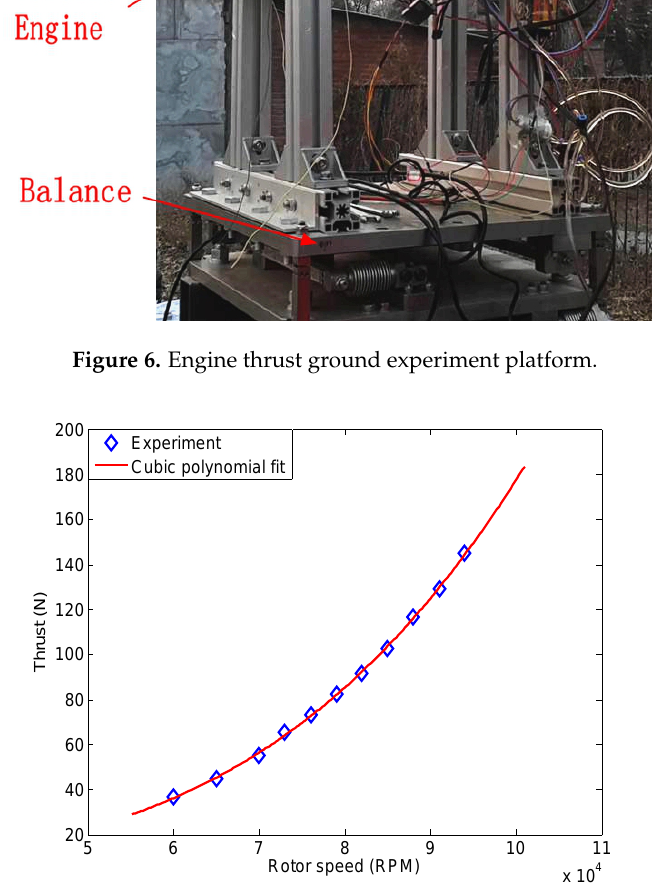
Figure 7. Relationship between the rotor speed and engine thrust in steady state